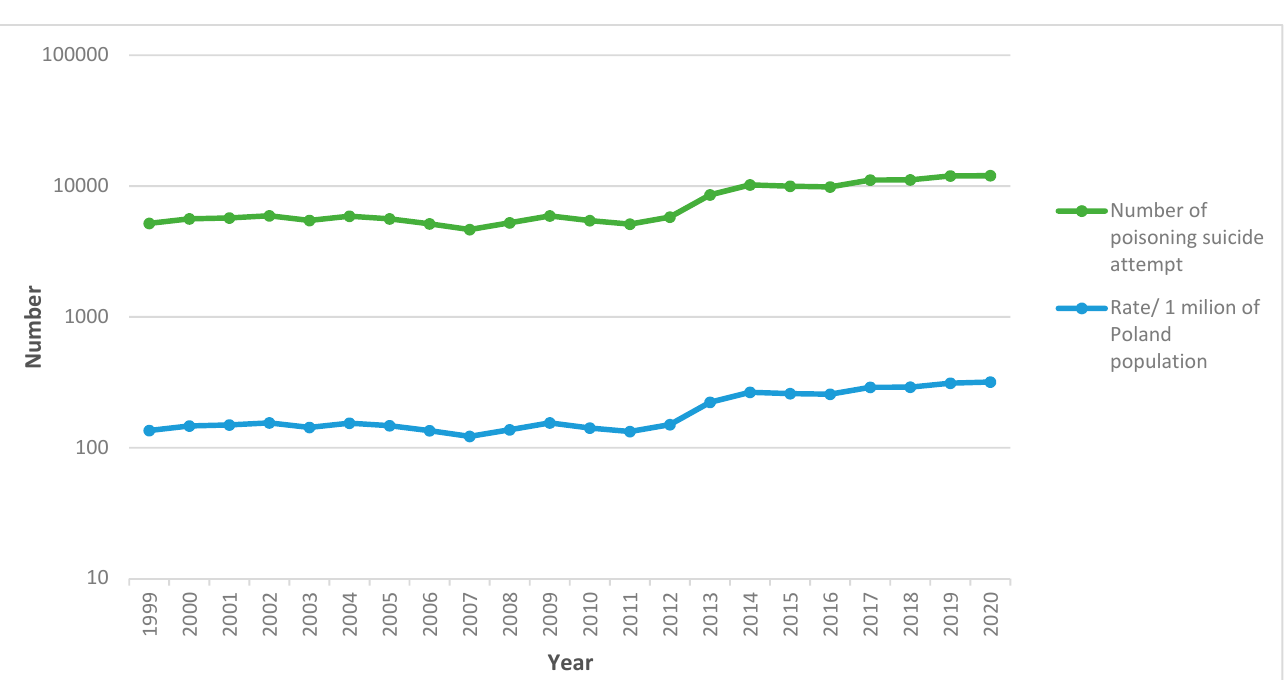
Figure 1. The numbers of suicide attempt and population rates caused by intoxication per 1 million of the population, Poland, 1999–2020 (source: own study).